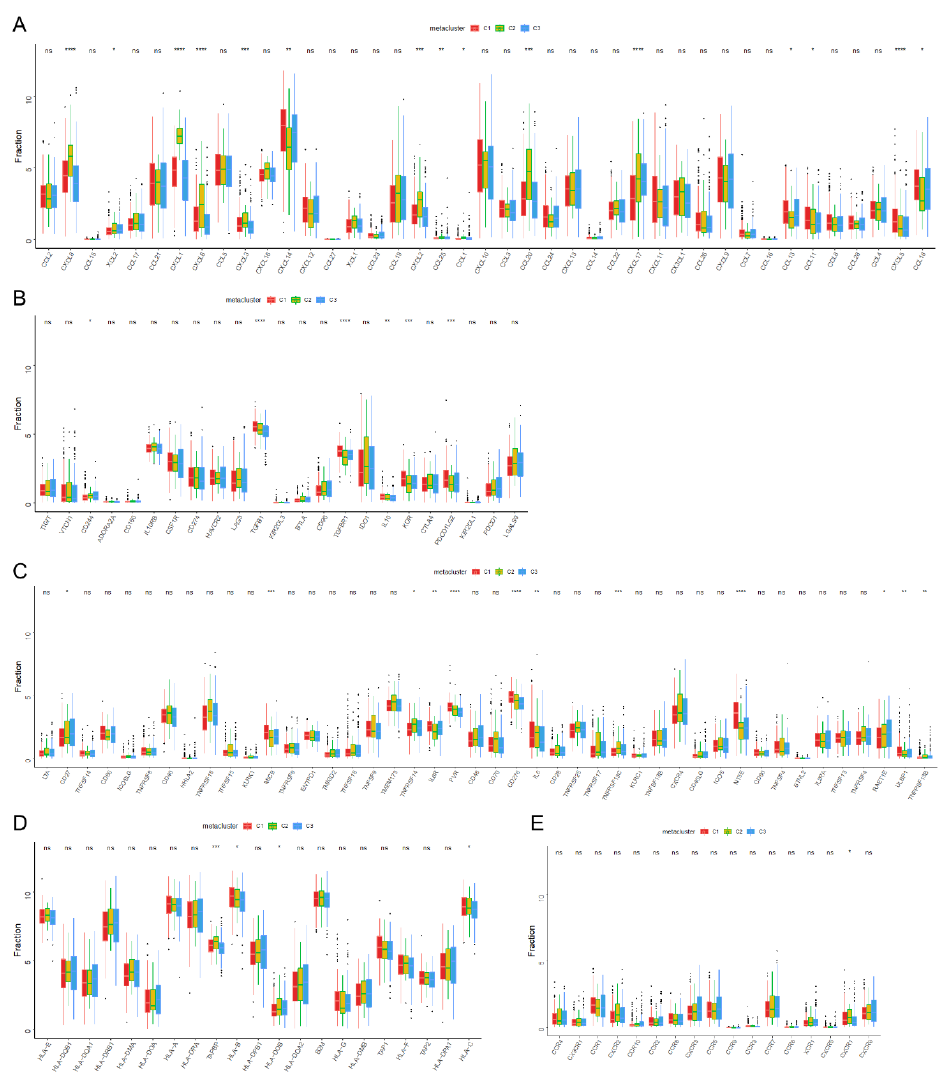
Figure 5. Analysis of immunomodulator and chemokine-related genes among immune subgroups. Differential expression analysis of chemokine-related genes ( A ), immunosuppressant-related genes ( B ), immunostimulator-related genes ( C ), MHC-related genes ( D ), and receptor-related genes ( E ) among immune subtypes. * p < 0.05, ** p < 0.01, *** p < 0.001, and **** p <